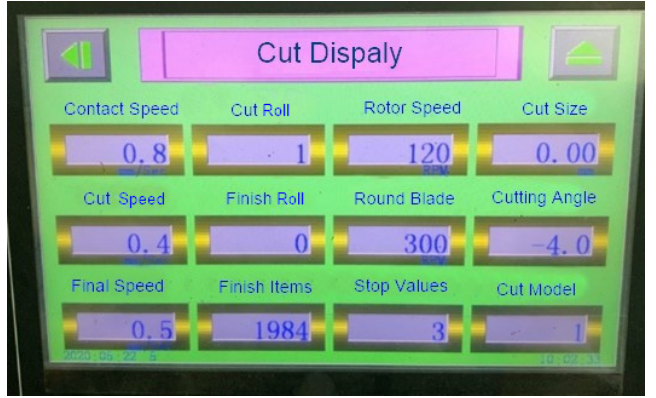
Figure 2. Traditional PLC panels.